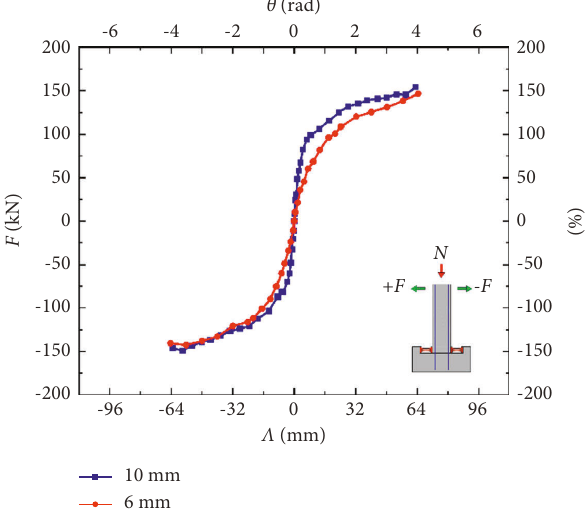
Figure 27: Comparison of skeleton curves of specimens with different energy dissipators